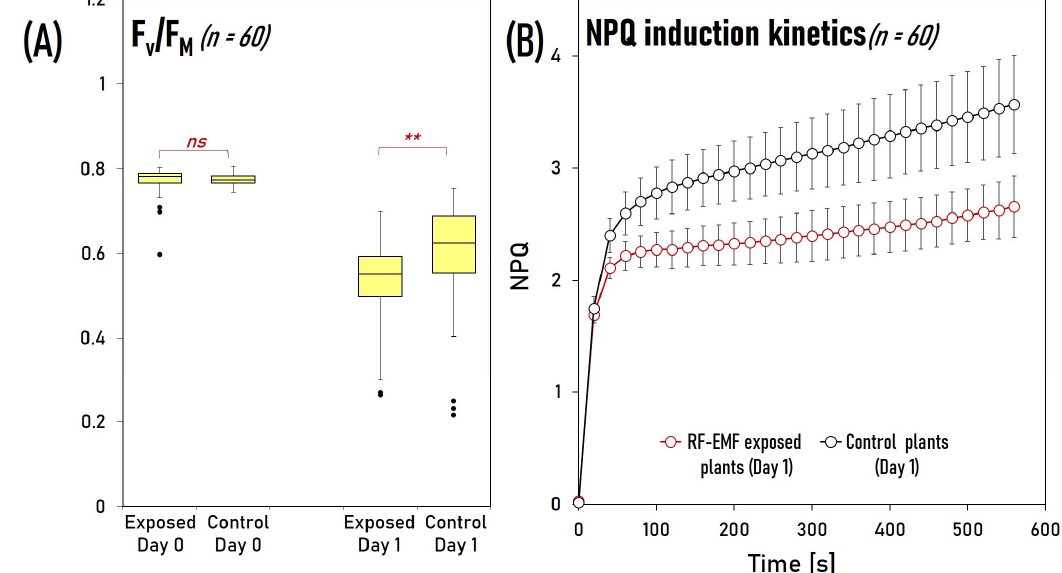
Figure 7. Comparison of the maximum photochemical quantum yield F V /F M of Photosystem II and the non-photochemical quenching (NPQ) of RE-EMF-exposed and control plants after one day of light stress treatment. ( A ) F V /F M of exposed and control plants before (Day 0) and after treatment (Day 1). Statistical symbols: ns—no statistically significant differences between control and exposed groups ( p > 0.05), **—statistically highly significant differences ( p < 0.01). ( B ) NPQ induction kinetics of exposed and control plants after one day light stress treatment. Error bars represent 95% confidence interval (n = 60). In all cases where the error bars do not overlap, the difference is statistically highly significant ( p < 0.01).